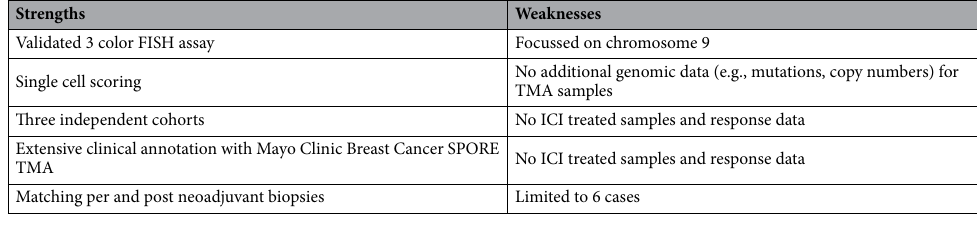
Table 6. Strengths and